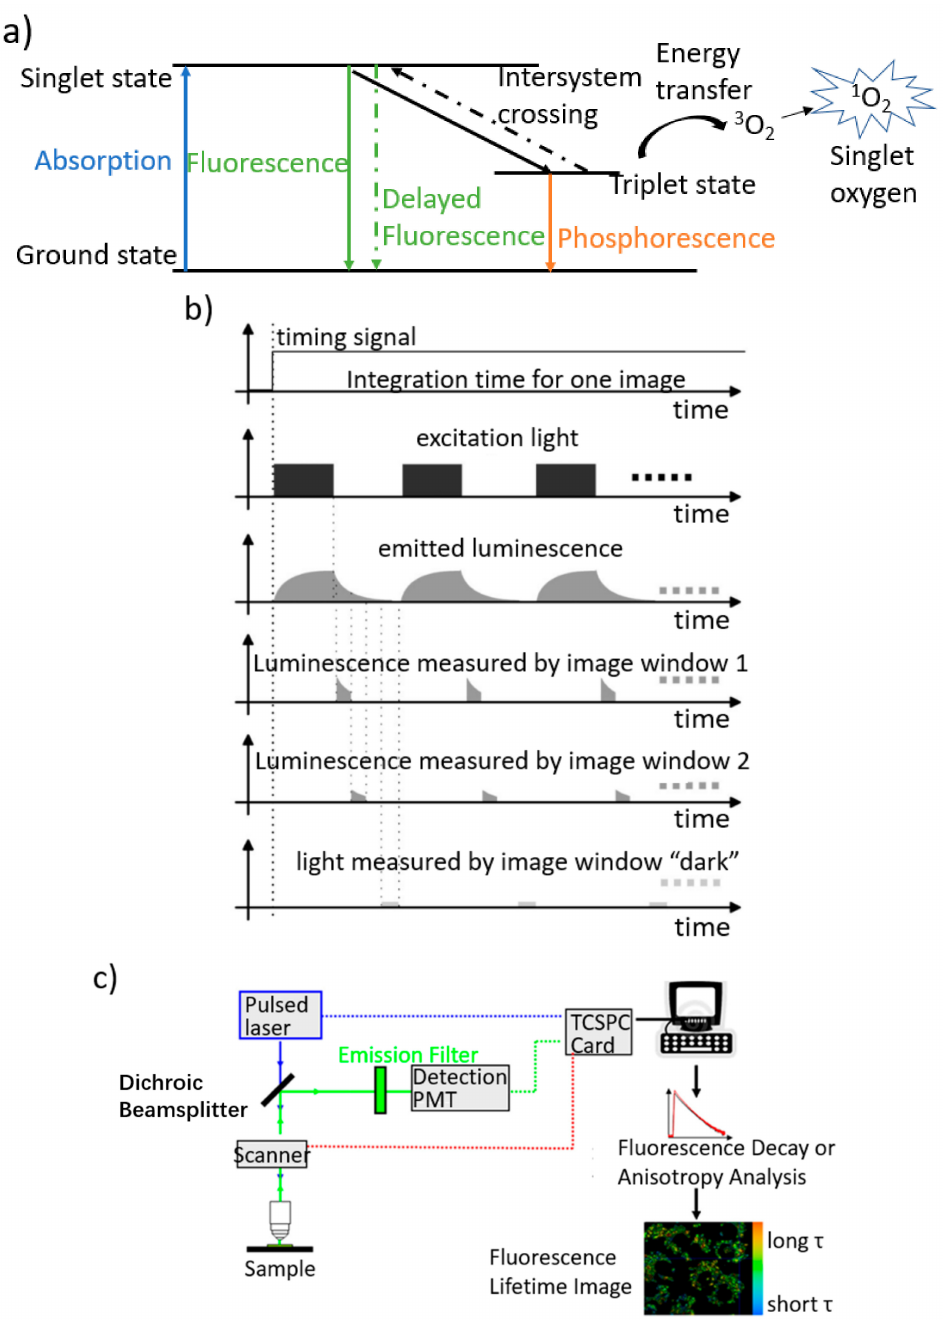
Figure 3. ( a ) Jablonski diagram for oxygen sensing mechanisms; ( b ) Structure of timing and light signals (reproduced with permission from [38]. Copyright Elsevier, 2001); ( c ) A schematic time-correlated single photon counting (TCSPC)-based scanning FLIM set-up (reproduced with permission from [41]. Copyright Elsevier,